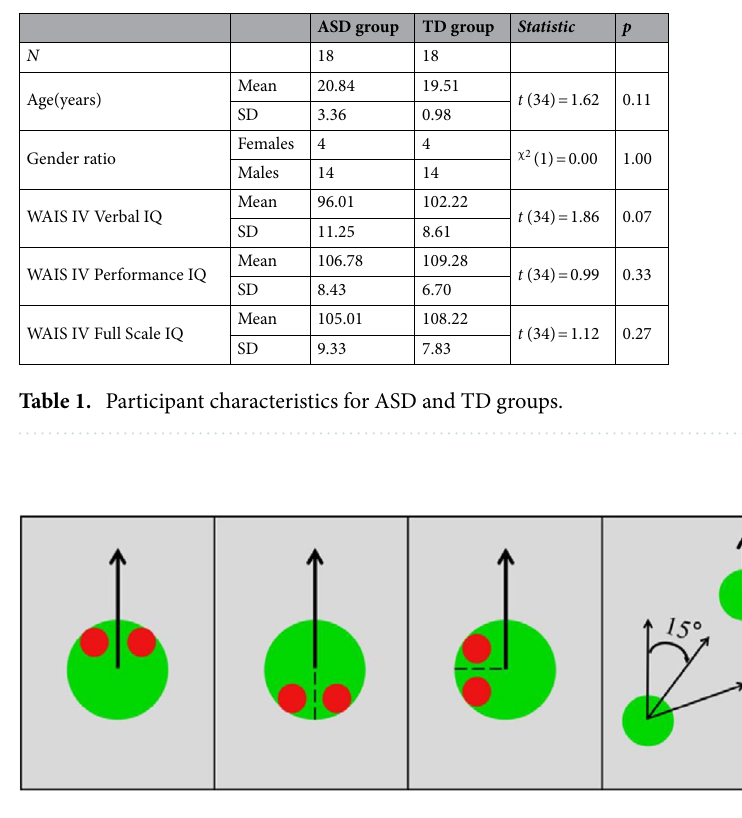
Figure 1. Illustration of the three cue conditions and chasing subtlety. The left image shows oriented cues, the center left one shows reverse cues, the center right image shows perpendicular cues, and the right image shows 15° chasing subtlety. The black arrows represent the direction of movement of the